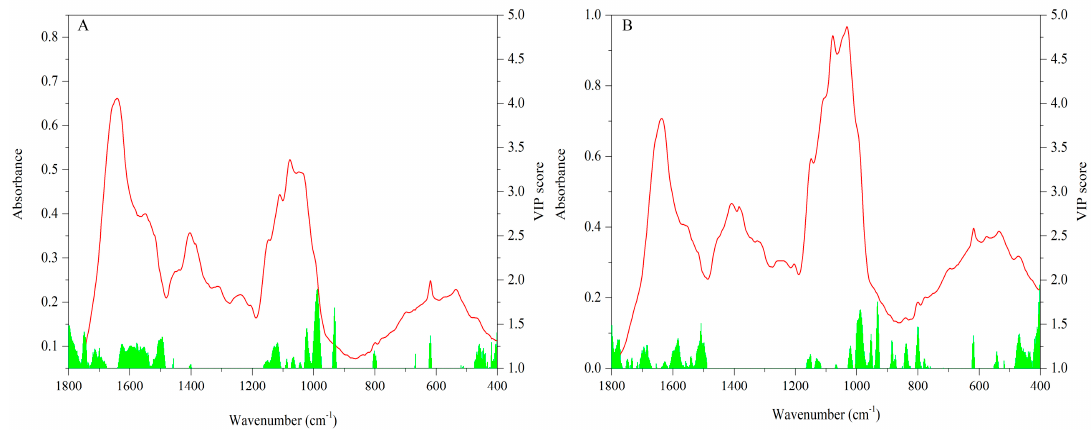
Figure 8. VIP scores of FT-MIR data for regional difference (( A ) Cap; ( B ) stipe).